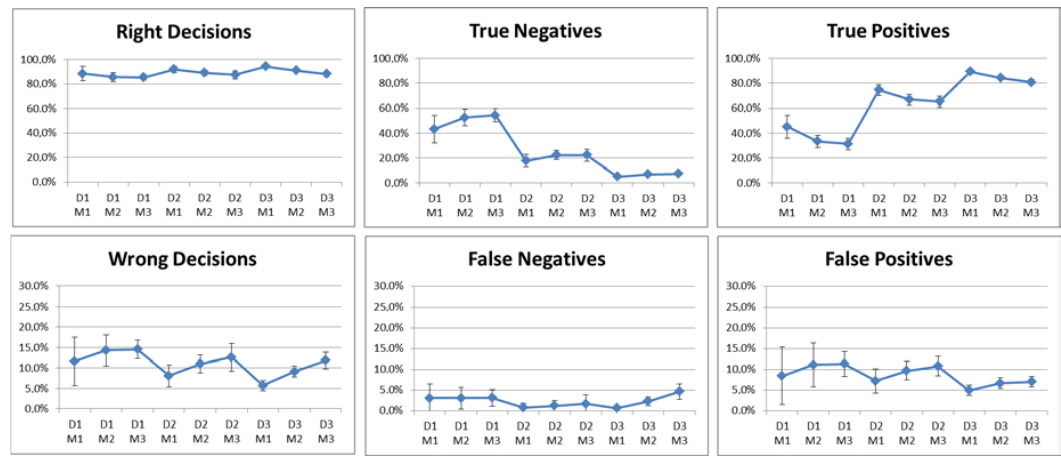
Figure 16. Inconsistency attack for Manhattan-Grid Scenario Experiments.